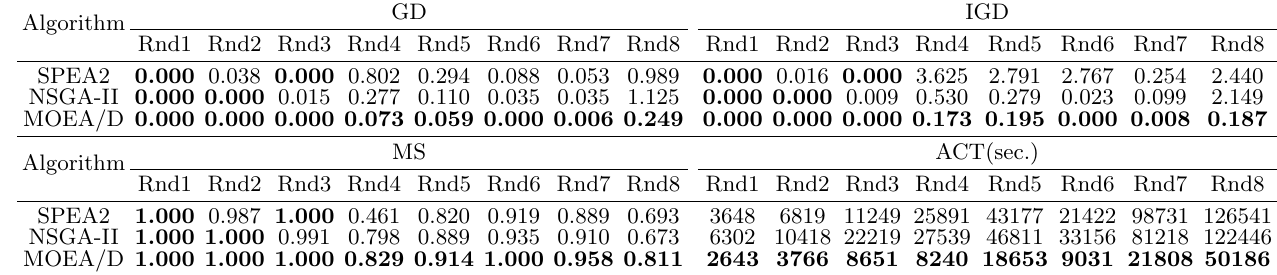
Table 2: Comparisons of different algorithms (best results are in bold) Algorithm